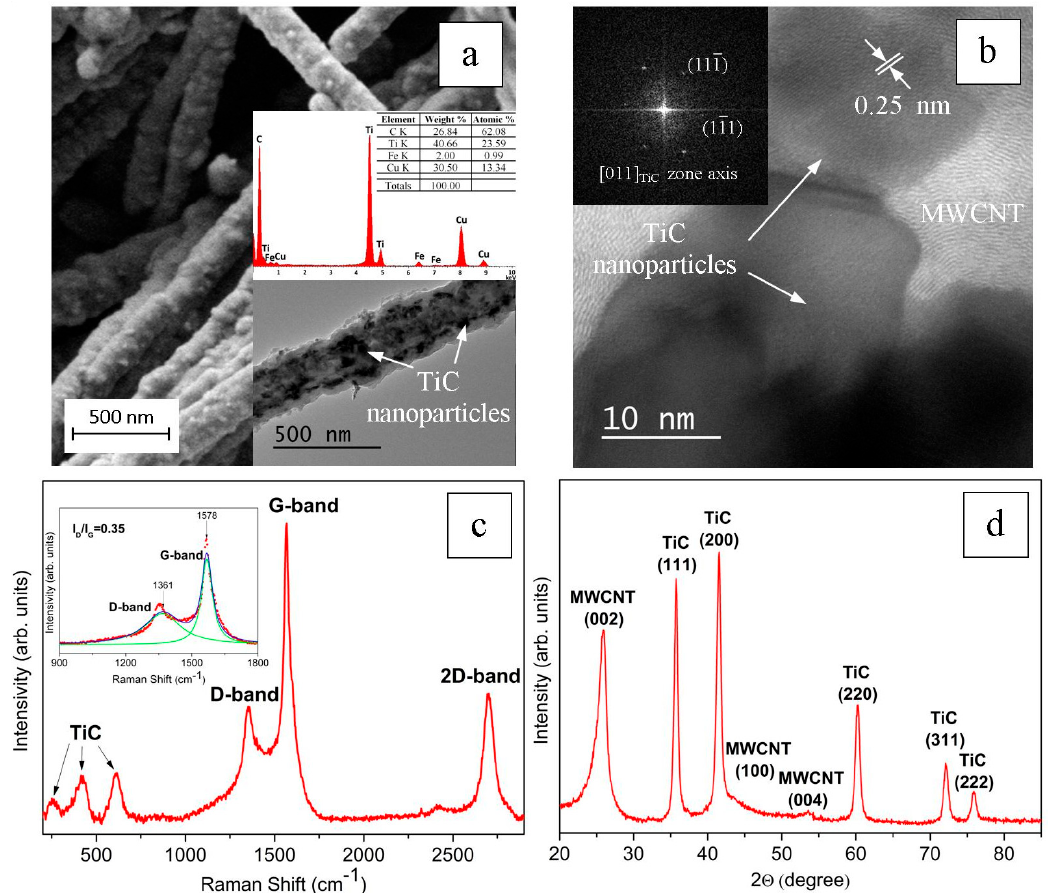
Figure 3. SEM image of MWCNTs coated with TiC nanoparticles ( a ): the inset in the lower right corner in Figure 3a shows a TEM image and EDS analysis data. An HRTEM image of an MWCNT with TiC nanoparticles in its walls ( b ): a Fourier image of the TiC crystal lattice image is shown in the inset in the upper left corner in Figure 3b. In the inset of Figure 3a and in Figure 3b, the pointing arrows indicate TiC nanoparticles. Raman spectrum ( c ) and XRD pattern ( d ) of an MWCNT coated with TiC nanoparticles.